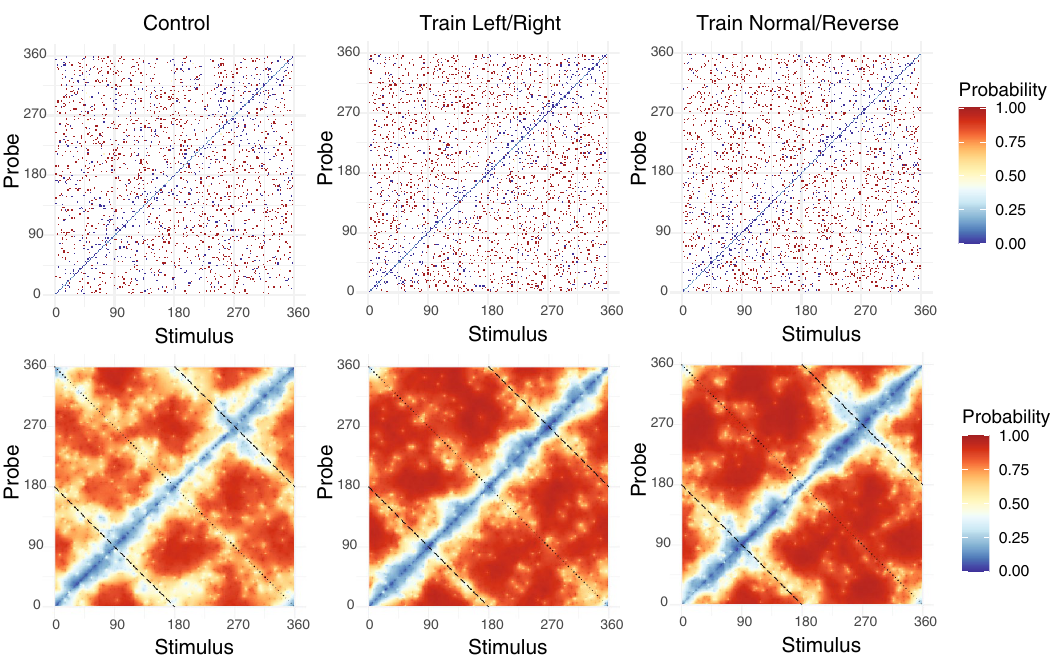
Figure 2. Visual change detection performance. Top row: Raw data from each of the three experimental conditions. The horizontal and vertical axes of a graph indicate the rake angles of the memory and probe stimuli, respectively. The color of a plot marker corresponds to the probability of reporting a change trial. Bottom row: Posterior mean change detection probability estimated via Bayesian model. The dashed and dotted lines overlaid on the graph correspond to “mirror stimuli” (see main text). (Figure generated using R version 4.0.3 and Adobe Illustrator